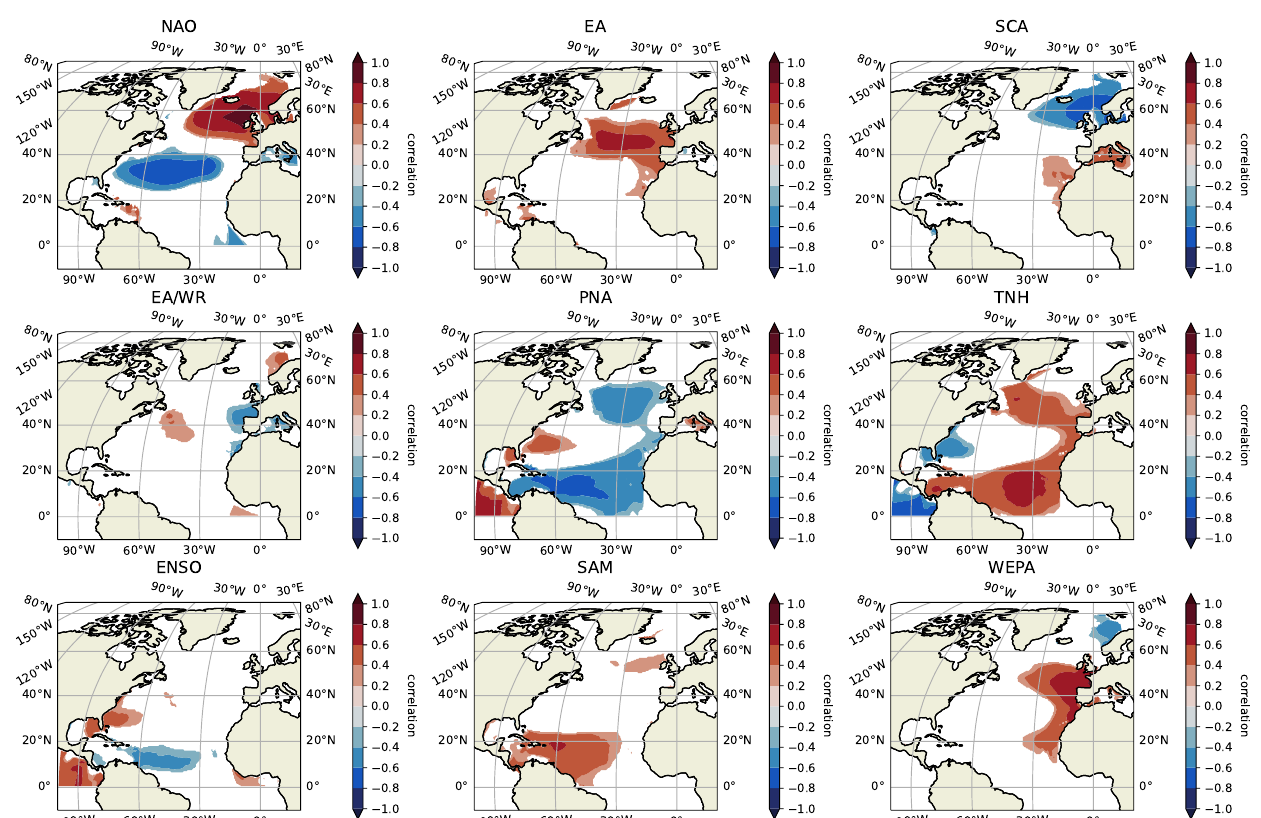
Figure 7. time correlation between ERA-5 JFM H s and the climate indices discussed in this review (1980–2018). Only 5% significant values are shown. From top to bottom, left to right correlations between H s and the following indices are shown: NAO, EA, SCA, EA/WR, PNA, TNH, ENSO, SAM and